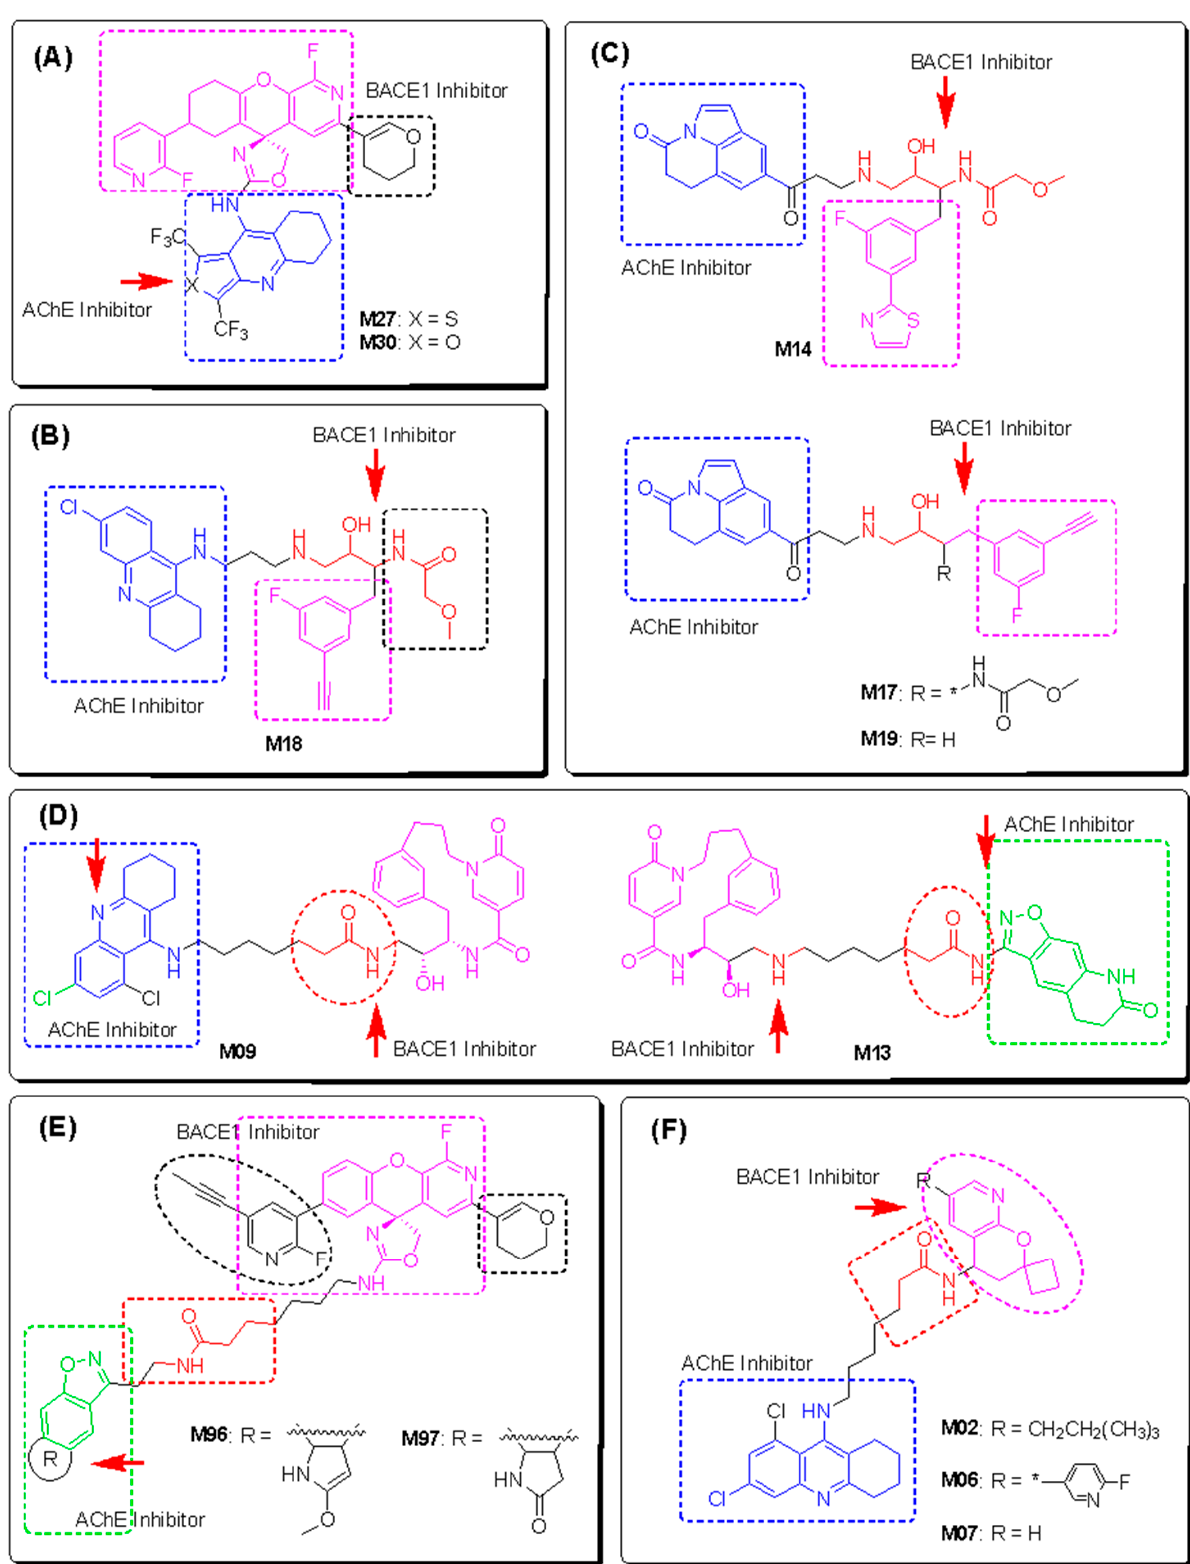
Figure 9. Structural design of novel AChE and BACE1 dual inhibitors. 13 designed compounds are sorted in 6 groups ( A – F ) according to their structural similarity. The active fragments are highlighted and colored according to their targets. The * indicates in each structure where that substituent group attaches to the designed molecule.